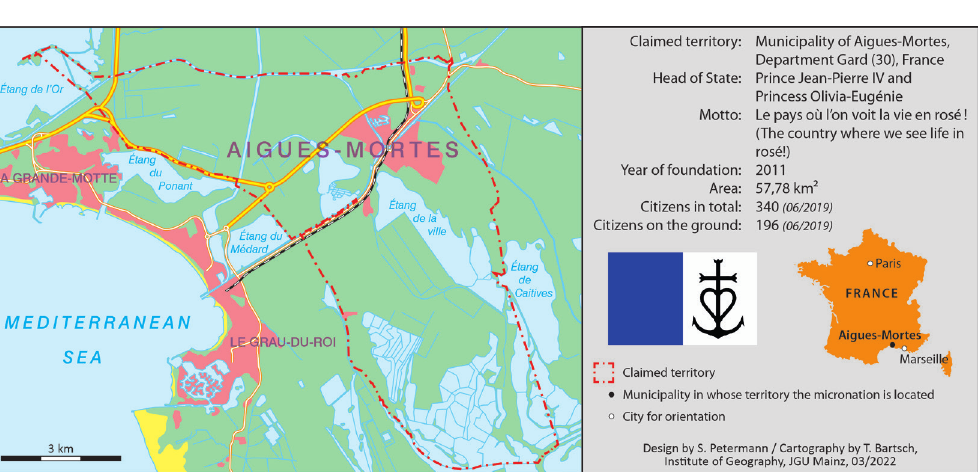
Fig. 1 Principality of Aigues-